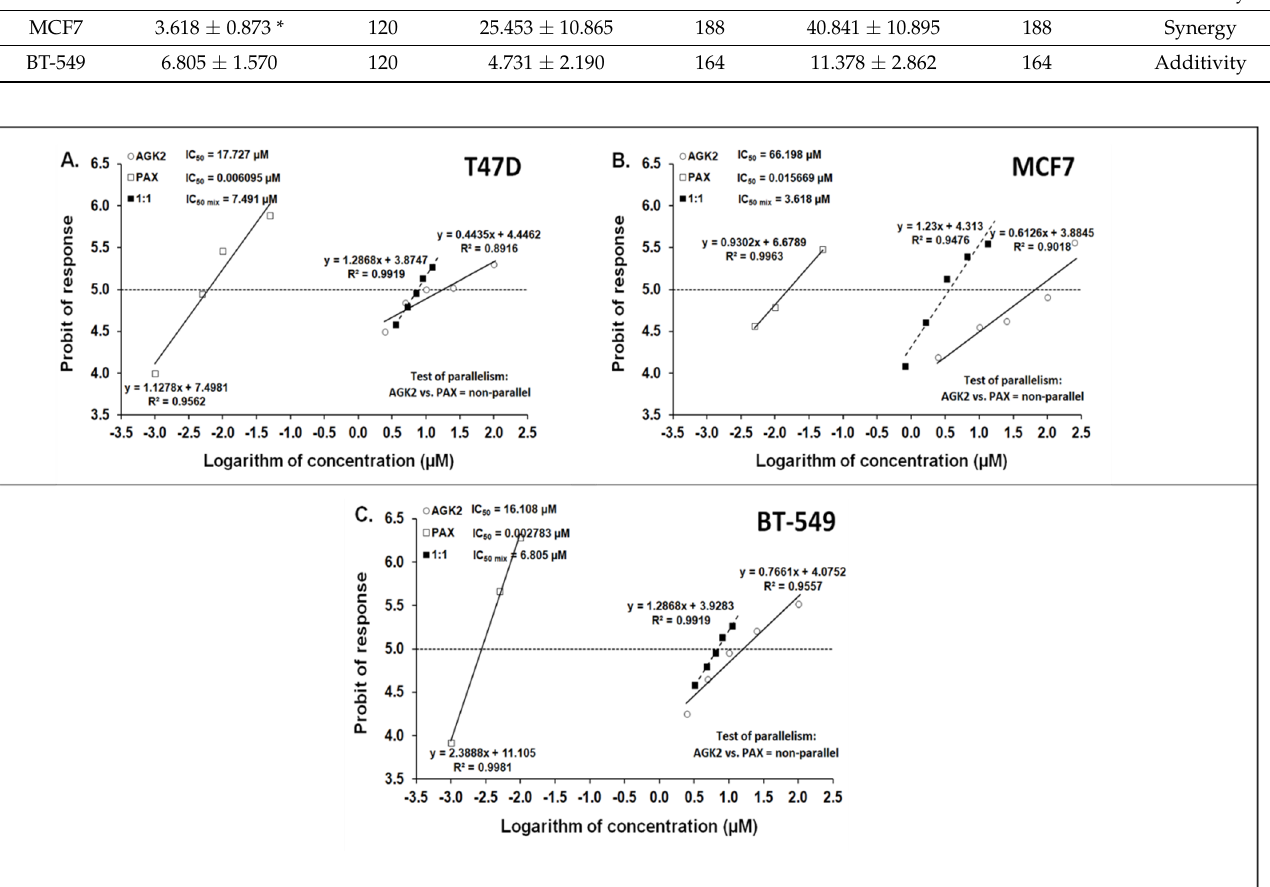
Figure 10. Log-probit concentration–effect relationship curves (CECs) for PAX and AGK2 administered alone and in combination (at the fixed-ratio of 1:1) for the T47D ( A ), MCF7 ( B ) and BT-549 ( C ) cells. Concentrations of PAX and AGK2 when administered individually and the mixture of these drugs in a 1:1 ratio combination were transformed into logarithms, whereas the antiproliferative effects in BC cell lines were measured using the MTT assay and transformed into probits [58]. Linear regression equations of CECs are presented on the graph, where y is the probit of the response, x is the logarithm (to the base 10) of a drug concentration, R2—coefficient of determination. The dotted line parallel to the X-axis and reflecting the fifth probit indicates the approximate IC 50 values for the studied drugs given alone and the mixture of PAX and AGK2 in a constant ratio of 1:1. Test of parallelism of CECs for PAX and AGK2 indicated that both lines are not parallel to each other.